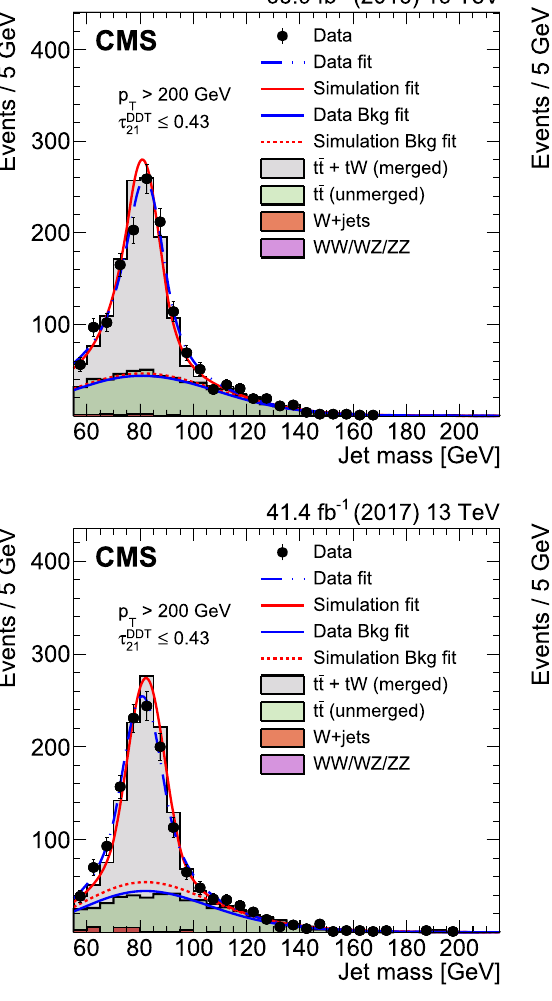
the fits are shown as dashed and dash-dotted lines. The fit to 2016 data is shown in the upper panels and the fit to 2017 data in the lower panels. The associated uncertainties are shown in Table 1 and discussed further in Sect.